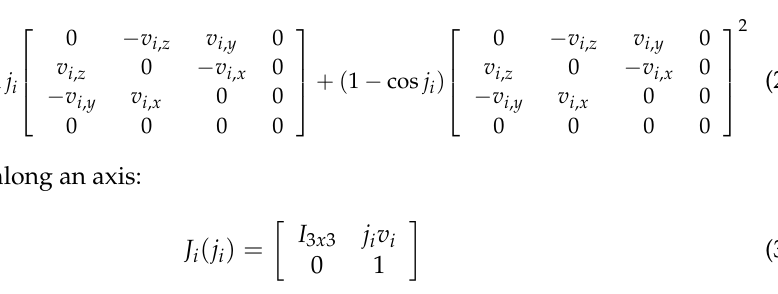
Figure 11. Motor torque waveforms of inchworm gait.